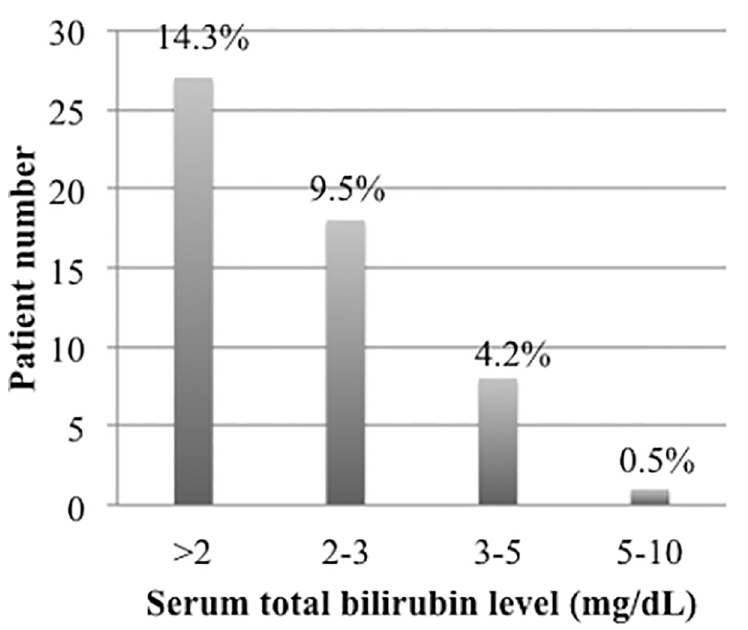
Fig 2. Hyperbilirubinemia (total bilirubin > 2 mg/dL) during the treatment.